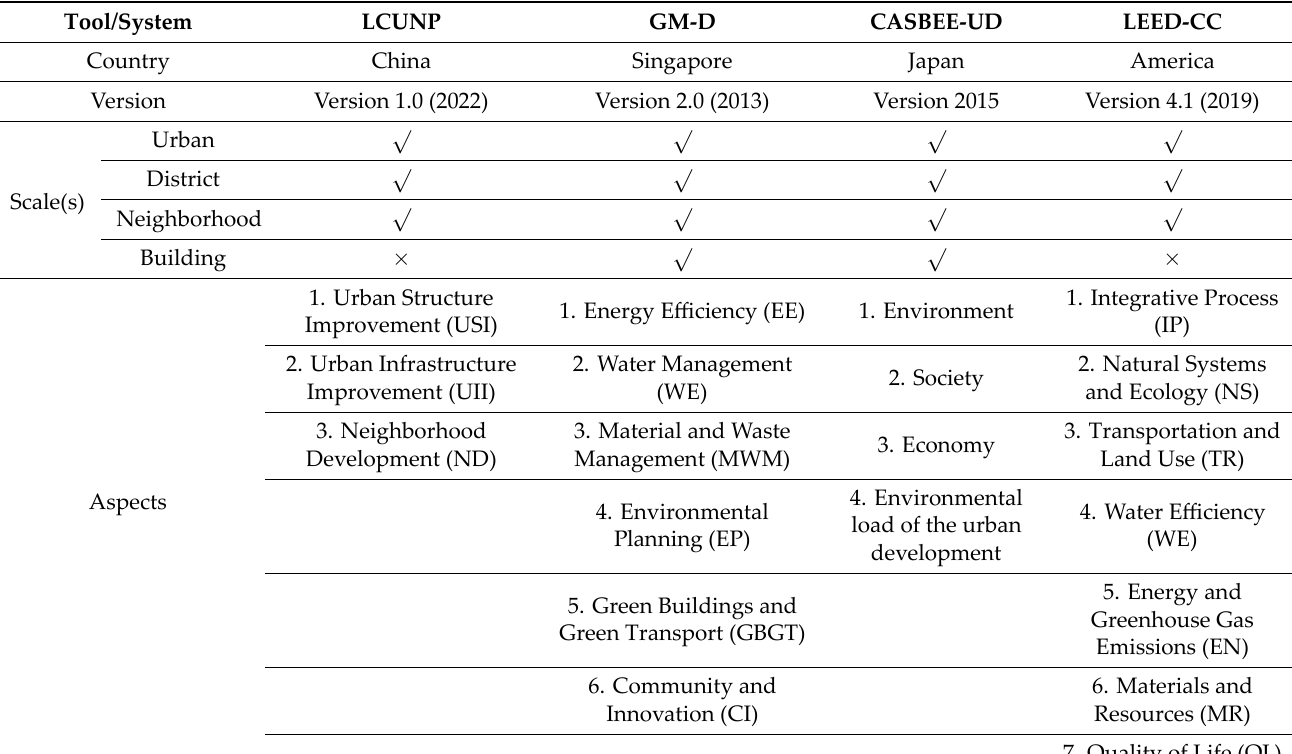
Table 13. Basic information of the selected assessment tools.